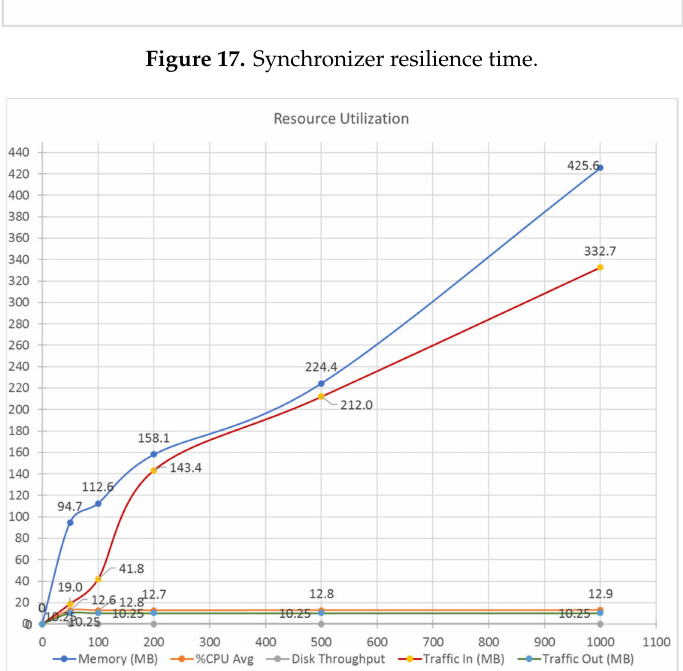
Figure 18. Resource utilization of the HealthyBlock